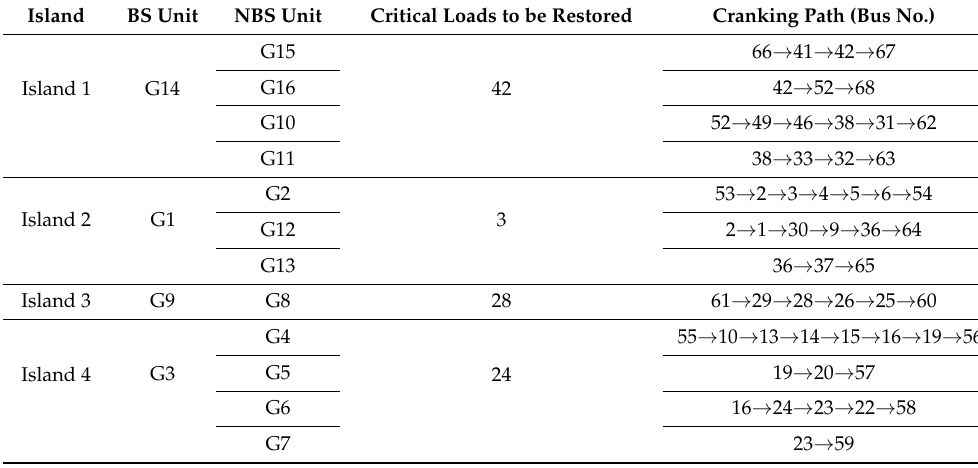
Table 10. Cranking paths from BS unit to NBS unit for the IEEE-68 bus